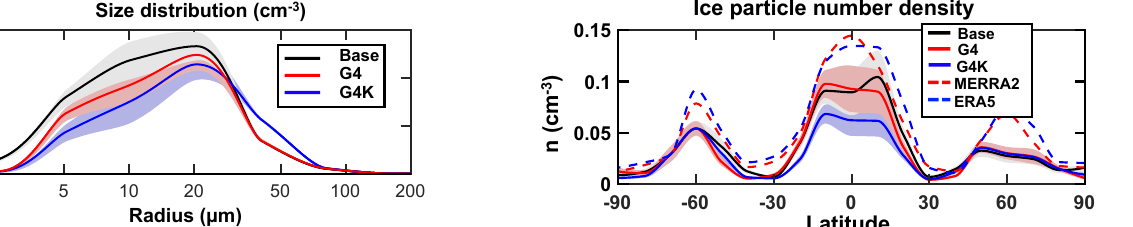
Ice extinction changes (km -1 )